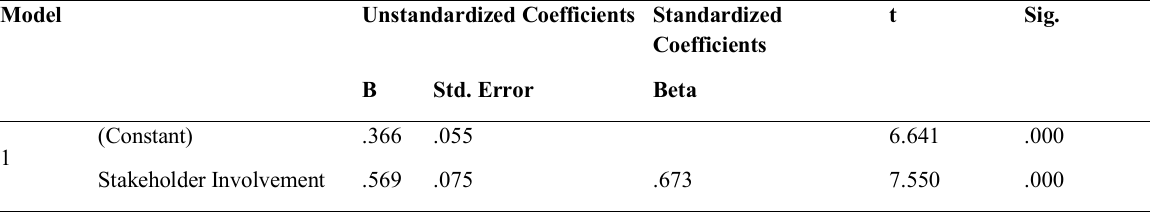
Table 4: Coefficients for Stakeholder Involvement and Tourism